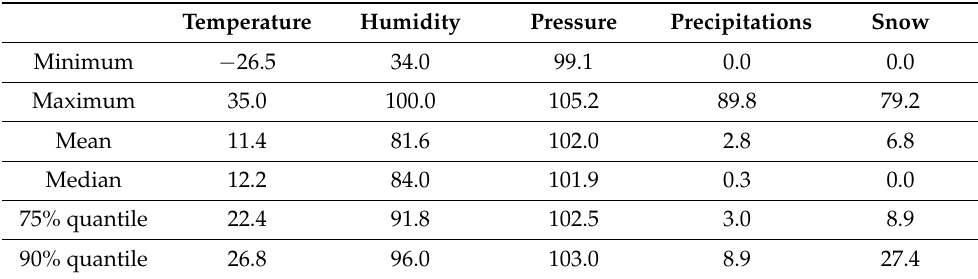
Table 4. Descriptive statistics for meteorological variables in Montreal from 1981 to